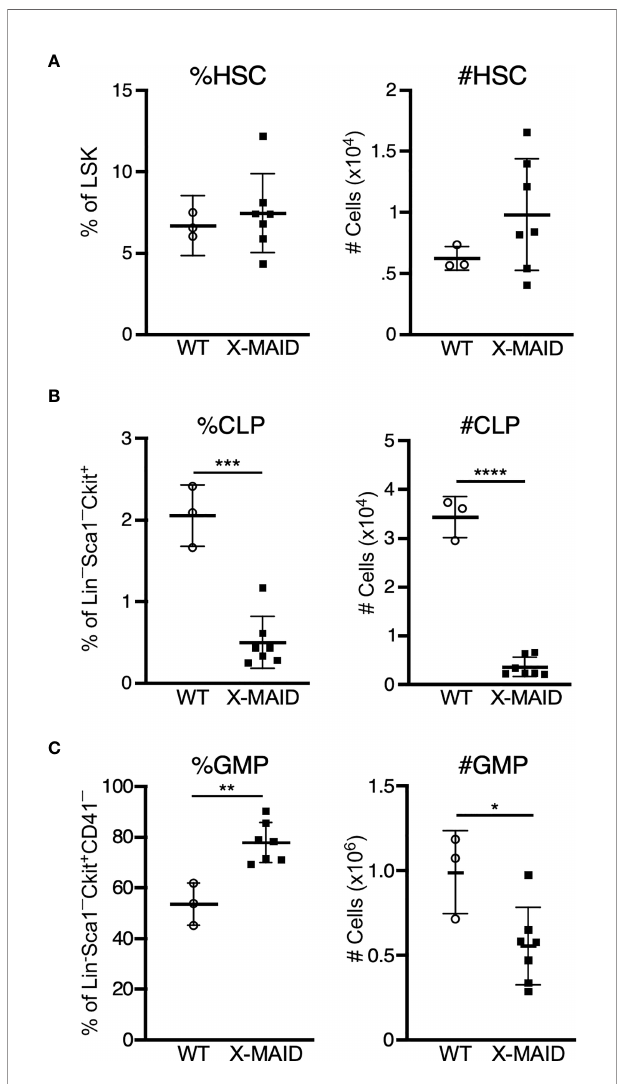
FIGURE 4 | Bone marrow of X-MAID mice shows a depleted lymphocyte progenitor population. Bone marrow cells from 3-5 week-old WT or X-MAID male mice were harvested, counted, and processed for fl ow cytometry. (A) Proportion and absolute number of hematopoietic stem cells (HSC) (CD150 + CD48 – ) displayed as gated on Lin – Sca1 + Ckit + (LSK) population. (B) Proportion and absolute number of common lymphoid progenitors (CLP) (Flt3 + IL7R a + ) displayed are gated on Lin – Sca1 LOW Ckit LOW . (C) Proportion and absolute number of granulocyte/macrophage progenitors (GMP) (%Fc g RII/III + CD150 – ) displayed are gated on Lin – Sca1 – Ckit + CD41 – . Data represent means ± StDev, with each point representing an individual mouse. Statistics were calculated using a Student ’ s t test, *p < 0.05, **p < 0.01, ***p < 0.005, ****p <